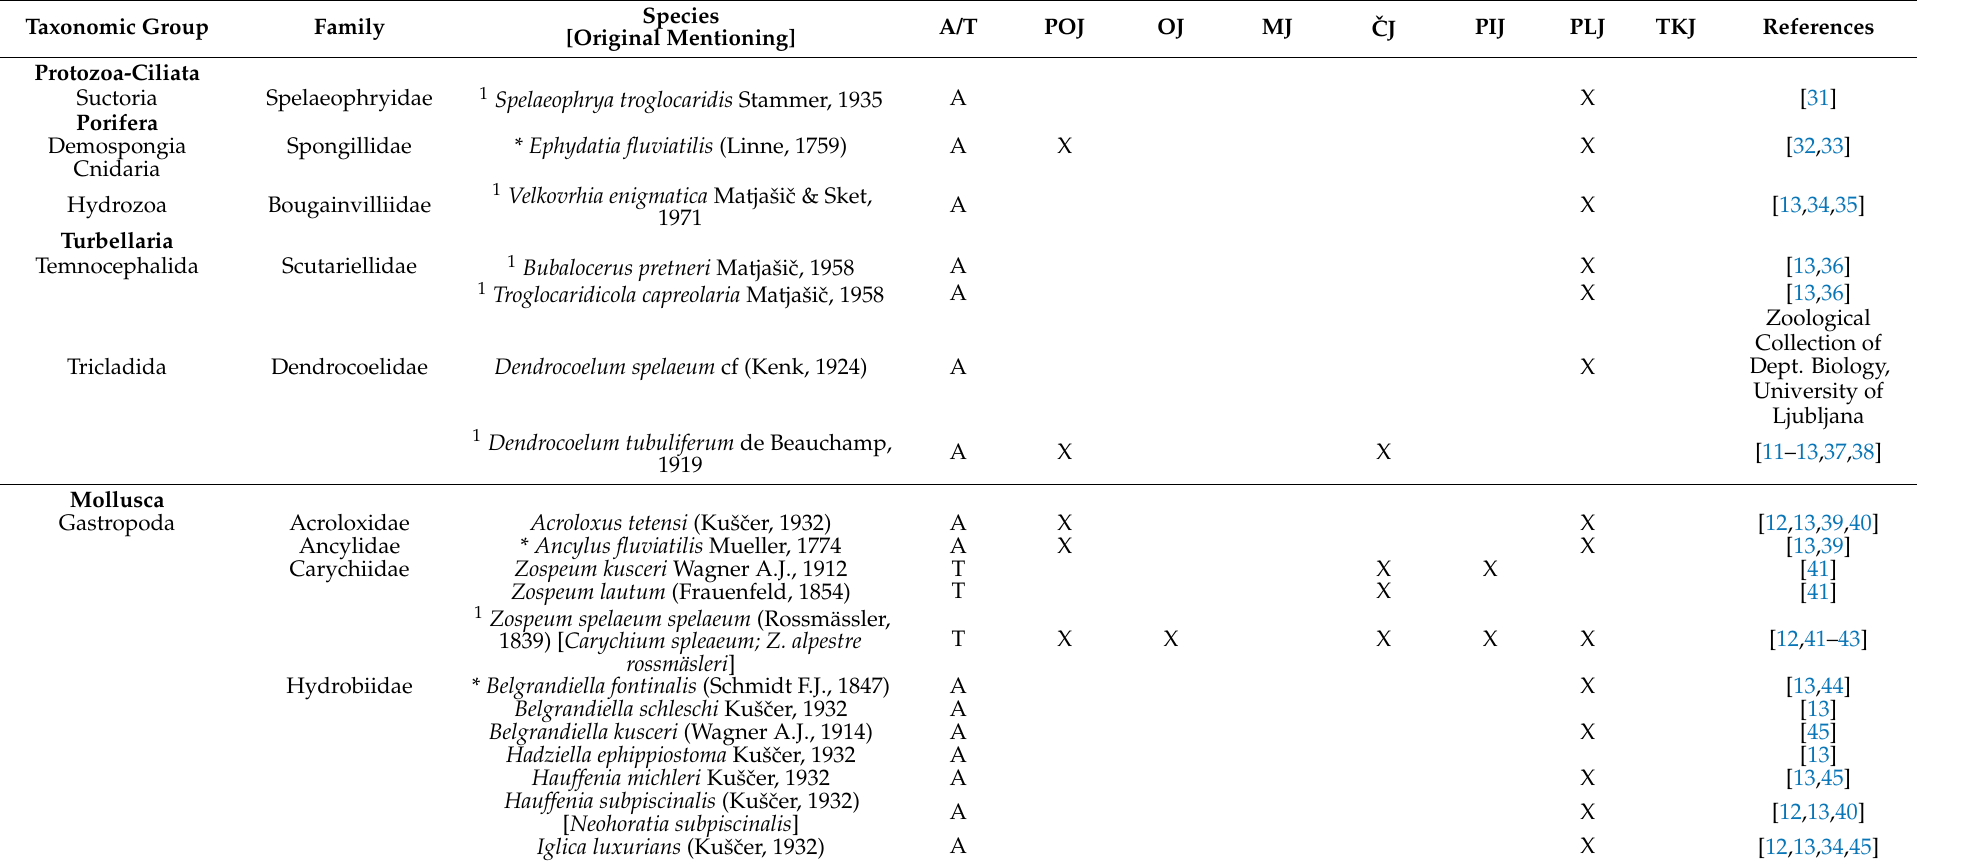
Table 1. The list of obligate subterranean (troglobiotic) species recorded in the Postojna-Planina Cave System in Slovenia. Species with type locality in PPCS are marked with 1 , and troglobiotic populations of surface species are marked with *. The letter in the column A/T marks whether the species is A—aquatic or T—terrestrial. If the species was reported from a specific cave(s) of the system, the X is under the abbreviation: POJ—Postojnska jama, OJ—Otoška jama, MJ—Magdalena jama, ˇCJ— ˇCrna jama, PIJ—Pivka jama, PLJ—Planinska